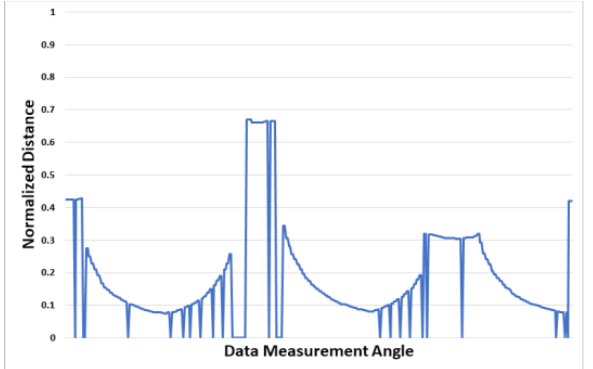
Figure 5. Normalized Range